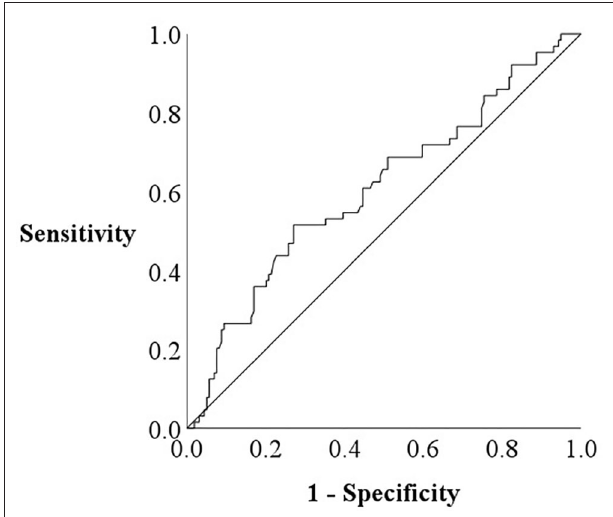
FIGURE 2 | Receiver-operating characteristic curve for the prediction of impaired peak VO 2 by